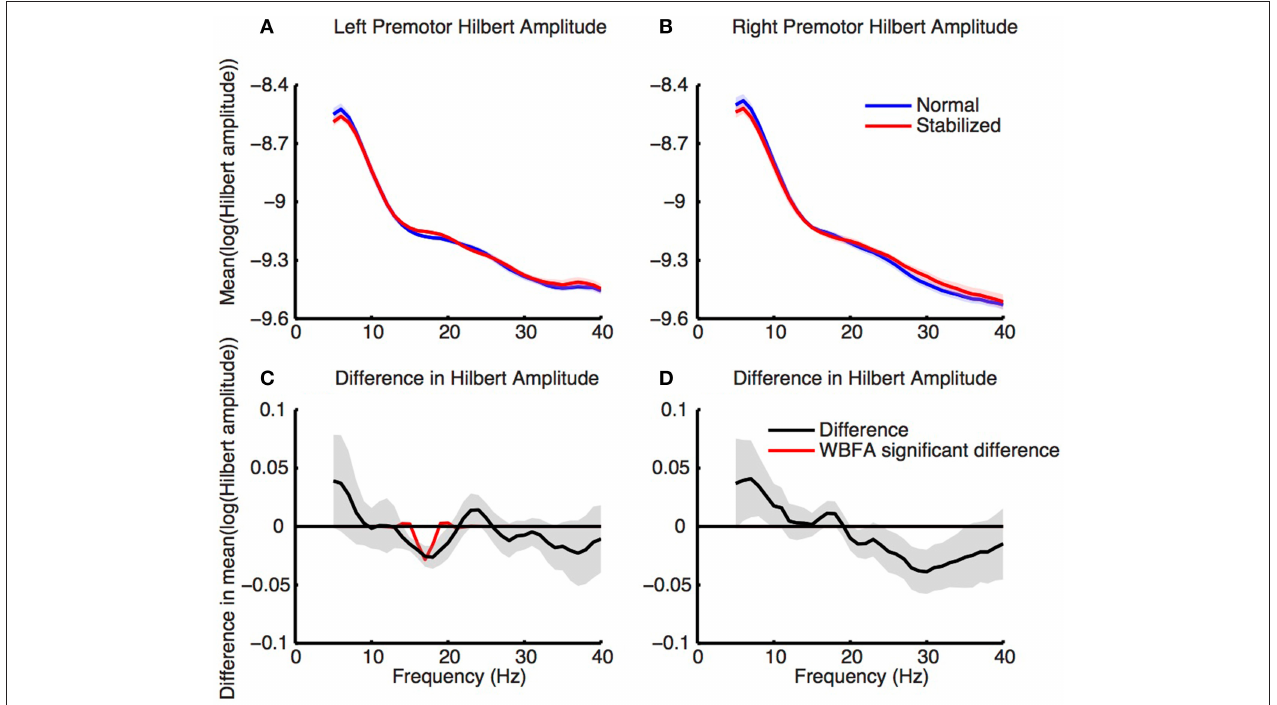
FIGURE 8 | Normalized power spectra (estimated via Hilbert transform) of (A) left and (B) right premotor areas during normal (blue) and stabilized (red) walking. Lower panels (C,D) represent differences between conditions, with values below zero representing higher power in the stabilized condition. Red lines in the lower panels are the inverse wavelet transform of the significant wavelets, thus indicating the statistically significant differences in power between conditions. Shaded areas represent standard errors.